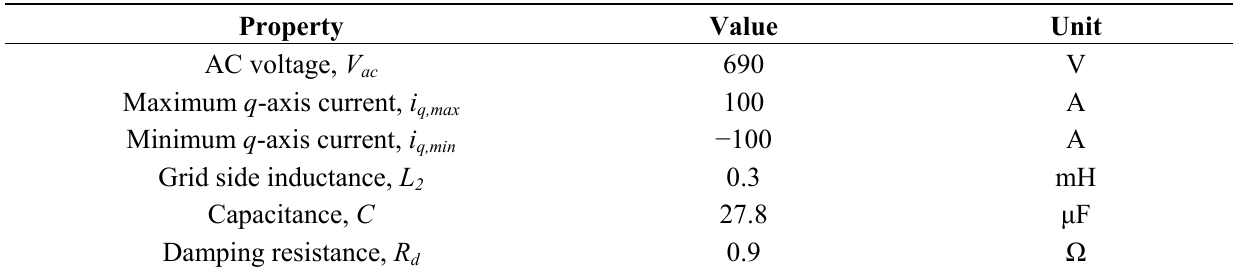
Table 3. Parameters of the DG.